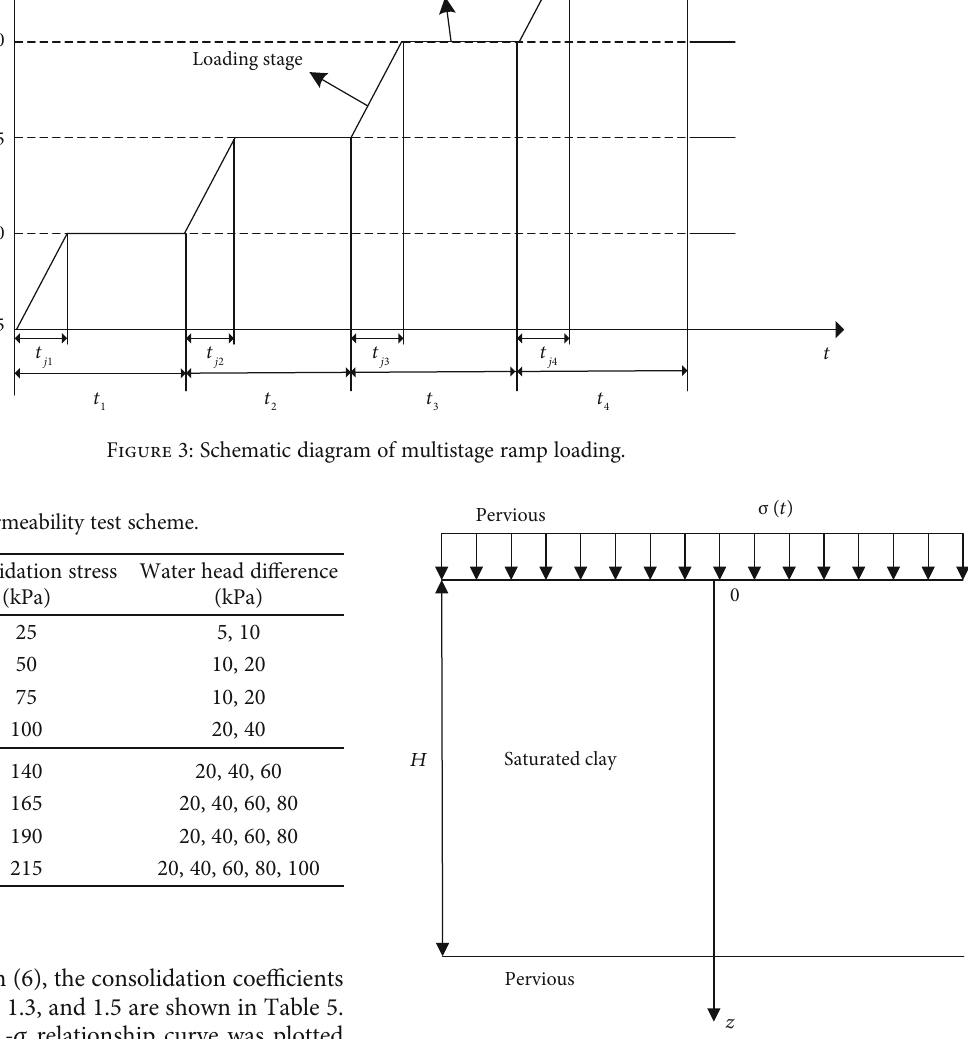
Figure 4: One-dimensional consolidation